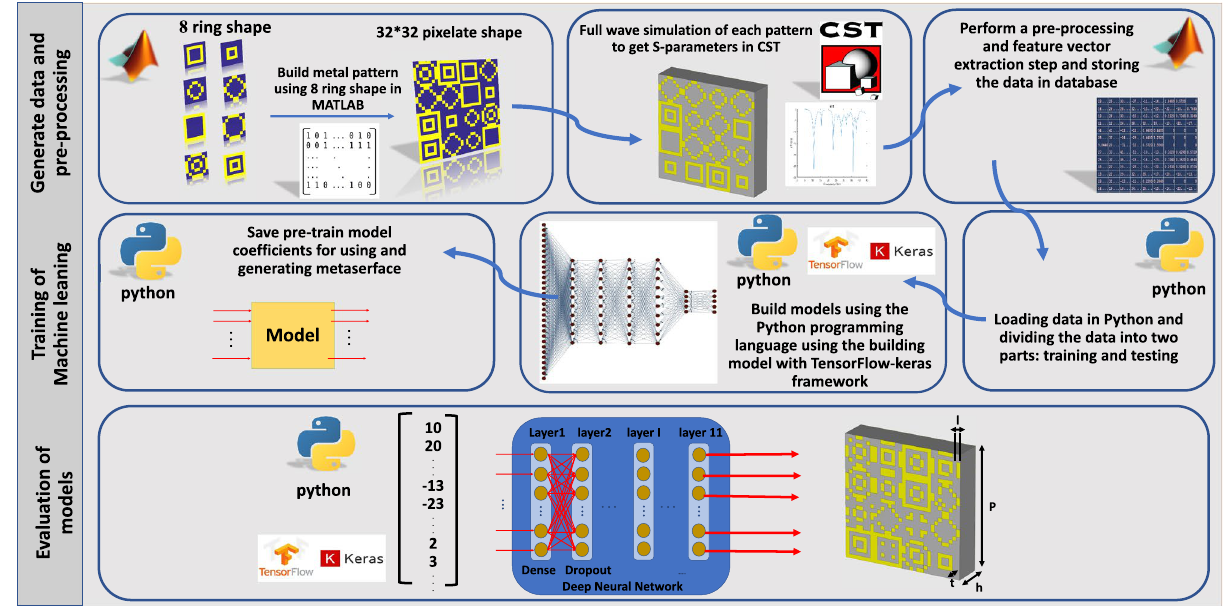
Figure 1. Sketch representation of the design process of DNN-based approach for metasurface inverse design. The process consists of three steps of generating data and pre-processing, training of machine learning, and evaluation of a